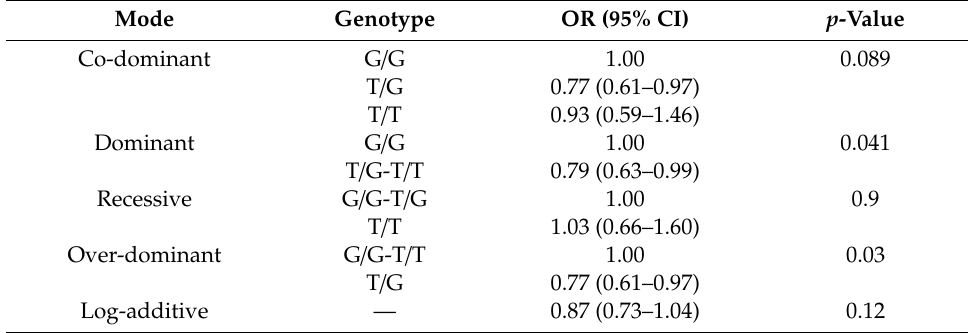
Table 3. Single-locus analysis for the association between CD33 rs3865444 and MS, in co-dominant, dominant, recessive, over-dominant, and log-additive